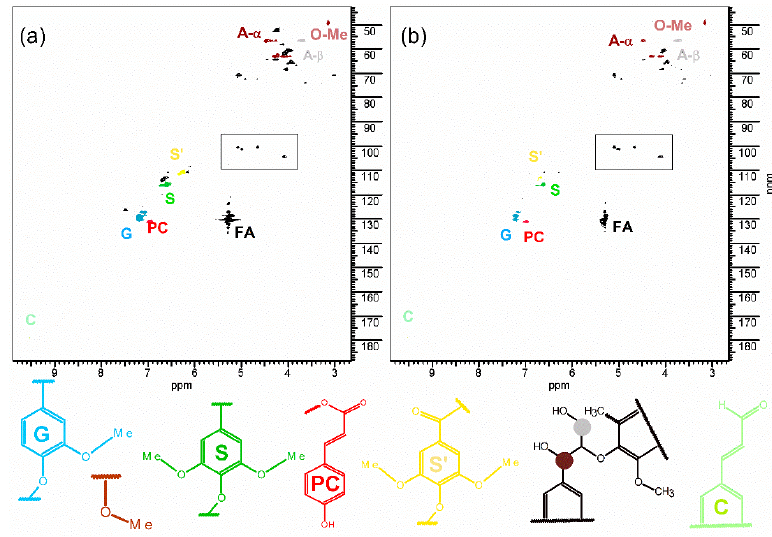
Figure 5. 1 H- 13 C HSQC of the lignin from cassava extracted in ( a ) genotype BRS Dourada (ETC); ( b ) hybrid 2009 12–20 (HTC). Legend: S: syringyl; S’: oxidized syringyl; G: guaiacyl; O-Me: methoxyl groups; PC: p-coumarate; C: cinnamic aldehyde; A: aryl ether with A- α : α – O –4 and A- β : β – O –4; FA: fatty acids bonded to lignin; square region: polysaccharides bonded to lignin. The presence of the main compounds from lignin was detected as syringyl (characteristic signals 1 H/ 13 C: 6.60/115.4 ppm) and guaiacyl (characteristic signals 1 H/ 13 C: 7.14/126.9; 7.20/128.5; 7.20/129.7 ppm). In addition, the oxidized syringyl (characteristic signals 1 H/ 13 C: 6.34/111.2 ppm), p-coumarate (characteristic signals 1 H/ 13 C: 6.96/130.8